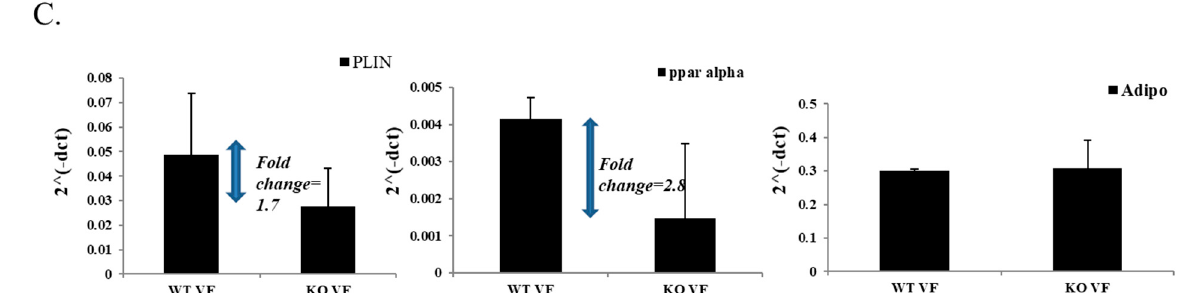
Figure 5. PPAR γ expression in KO and WT male mice. RNA extraction from kidney adipose tissue from KO and WT mice was prepared and cDNA synthesis was performed. ( A ). A fragment of the PPAR γ gene was amplified by PCR reaction and uniformity of the samples was confirmed by the murine GAPDH housekeeping gene. PPAR γ expression levels in samples, shown on the right, were determined by densitometry (TINA 2.0). ( B ). Quantitative real-time PCR was performed to confirm the results above. ( C ). Quantitative real-time PCR was performed to determine the levels of perilipin 1, PPAR α , and adiponectin in visceral fat.